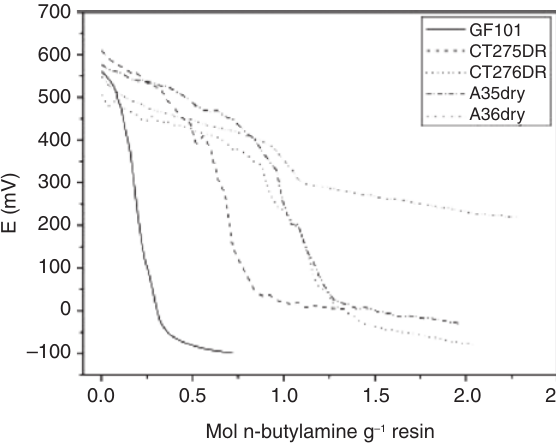
Figure 7: Potentiometric titration of the sulfonic acid-based ion exchange